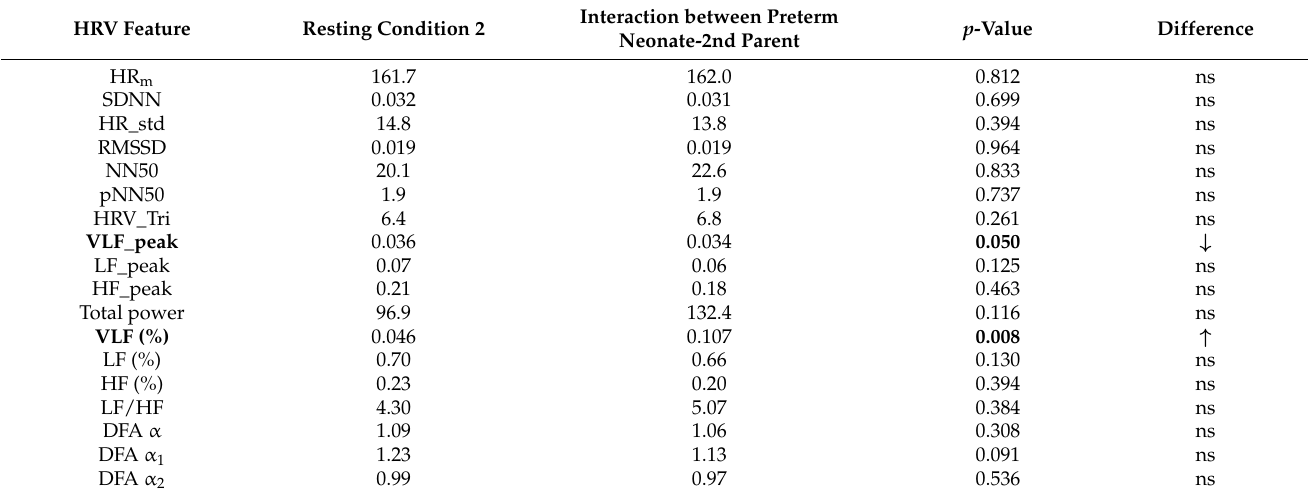
Table 10. Comparison of preterm infants’ HRV parameters between resting condition 2 and interac- tion with the 2nd parent.